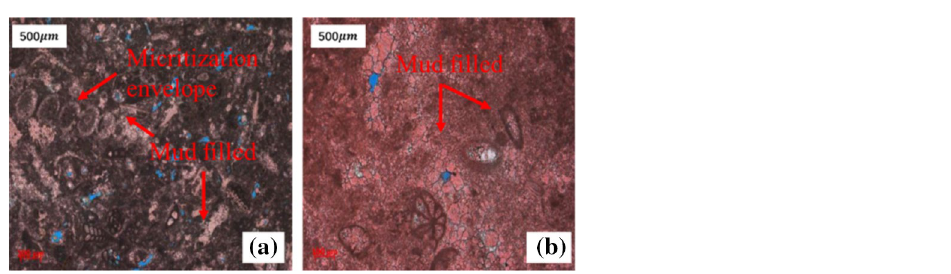
Figure 8. Comparison of thin sections of packstone ( a ) and wackstone ( b ) at 2450–2451 m in Well